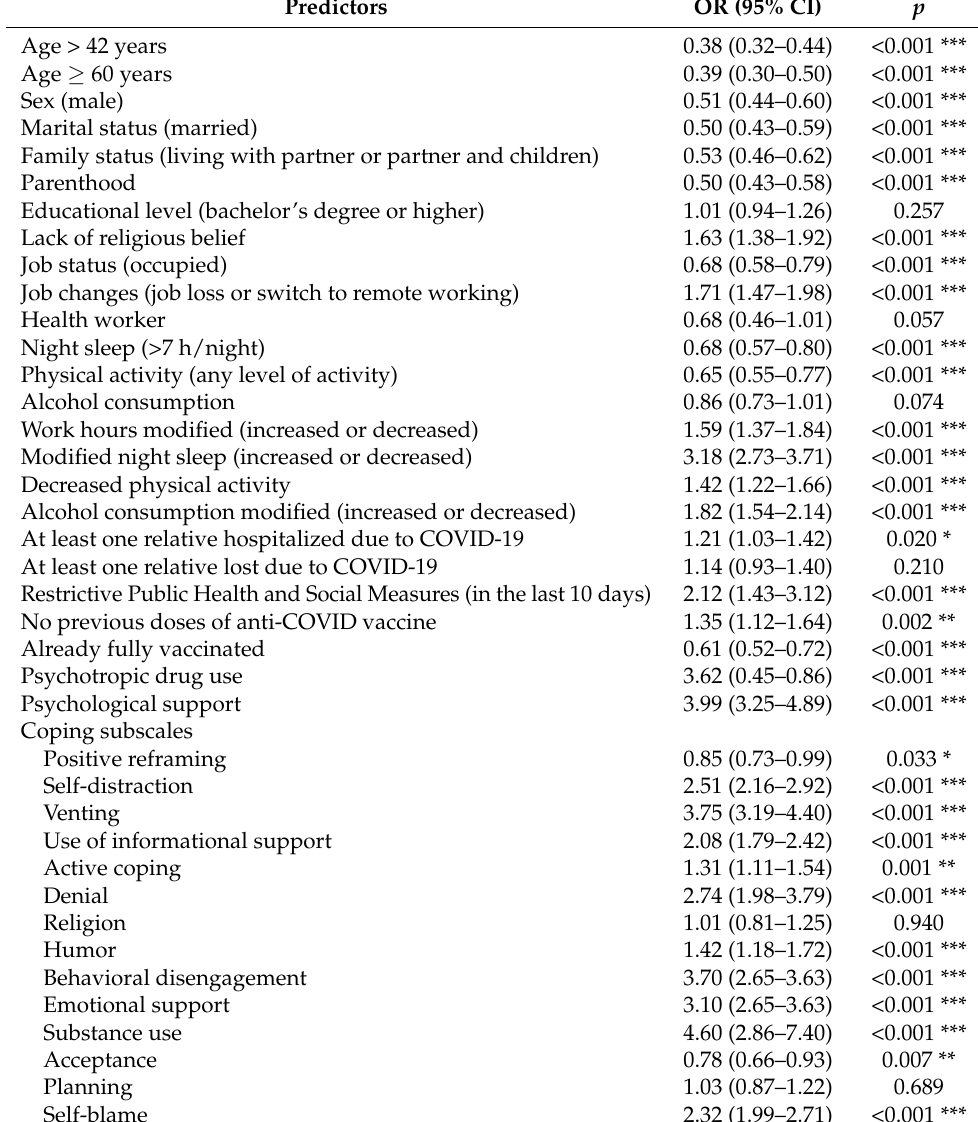
Table 2. Univariate logistic regression analysis of factors associated with moderate-to-severe anxiety (GAD-7 score ≥